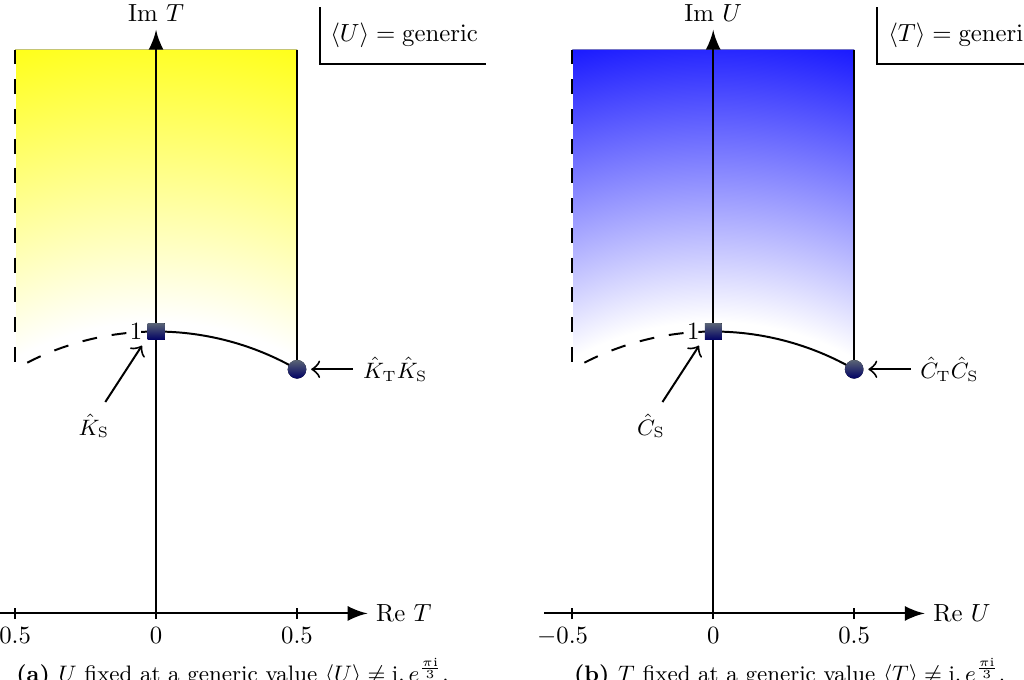
Figure 4 . Generators of nontrivial stabilizer subgroups at special points in moduli space. (a) For generic h U i , only at h T i = i (square) and h T i = e π i 3 (bullet) the stabilizer subgroup is nontrivial. The corresponding stabilizer subgroups are H = h ˆ K S i ∼ = Z 2 and H (cid:0) (cid:1) = h ˆ K T ˆ K S i ∼ = Z 3 . (i , h U i ) e π i 3 , h U i (b) For generic h T i , the results are equivalent due to mirror symmetry ˆ M , which exchanges T ↔ U , ˆ K ˆ C ˆ K ˆ C T ↔ T and S ↔ S